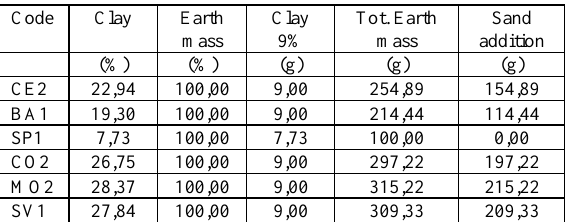
Table 1. Addition of sand needed each 100 g of earth,